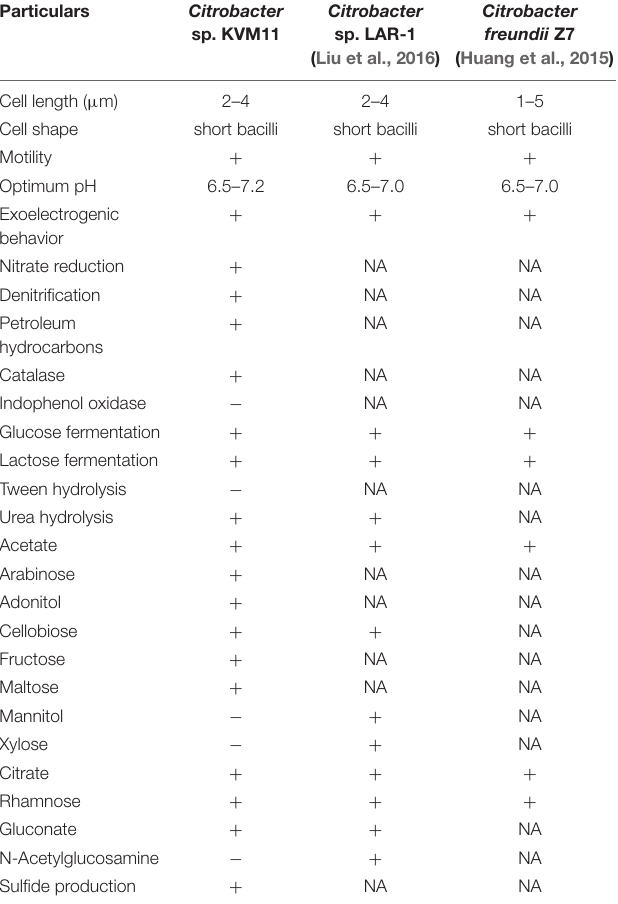
TABLE 1 | Phenotype and metabolic properties of Citrobacter sp.